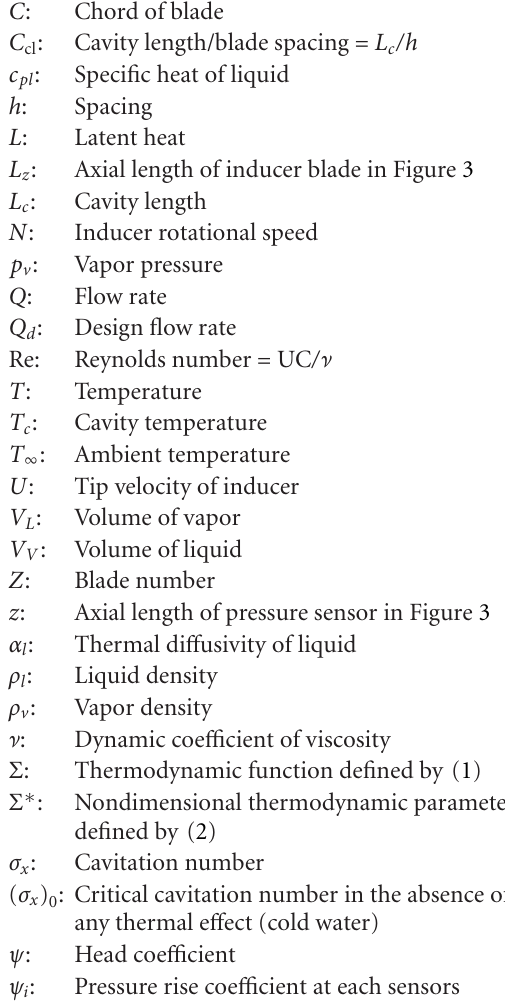
Figure 11: Comparison of the change of pressure rise between in liquid nitrogen and